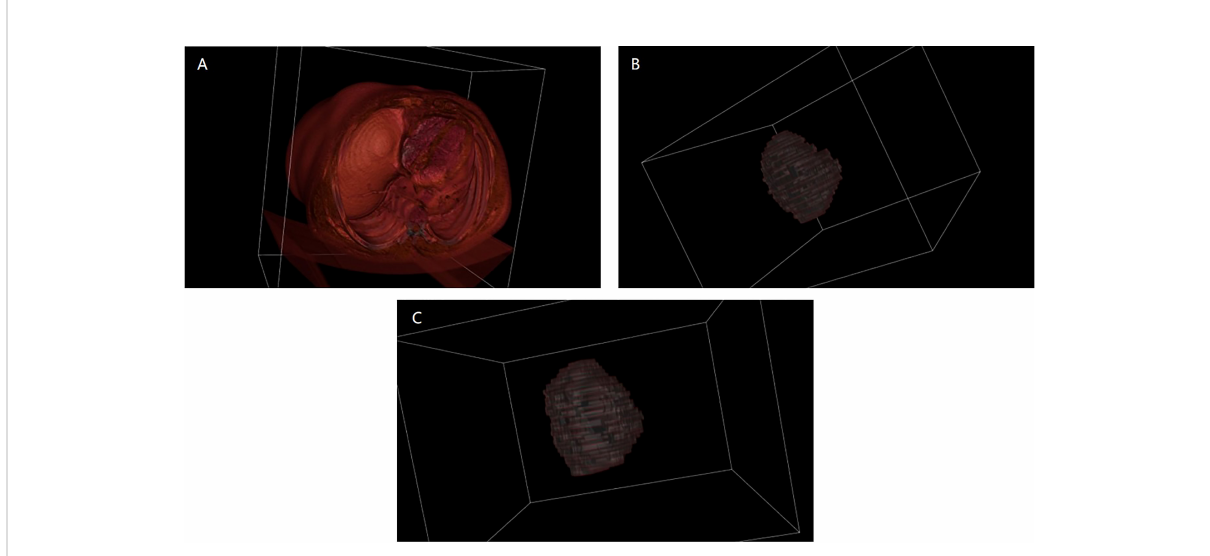
FIGURE 3 3D reconstruction visualization images before and after segmentation. (A) is the 3D visualization of the original CT image before segmentation; (B) is the 3D visualization after manually segmenting the tumor; (C) is the 3D visualization after segmenting the tumor using deep